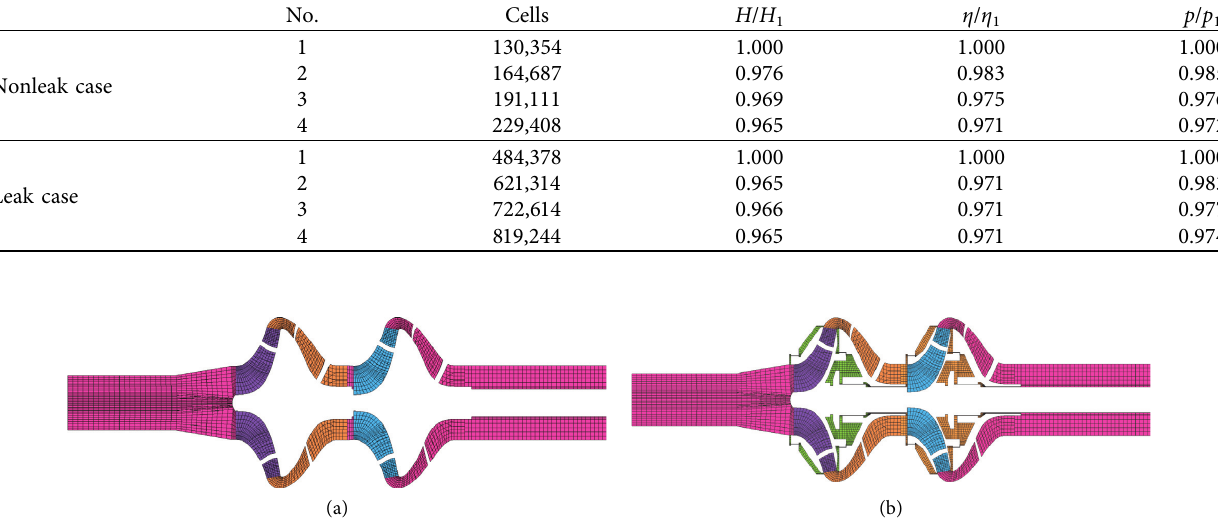
Table 3: Grid independence test.